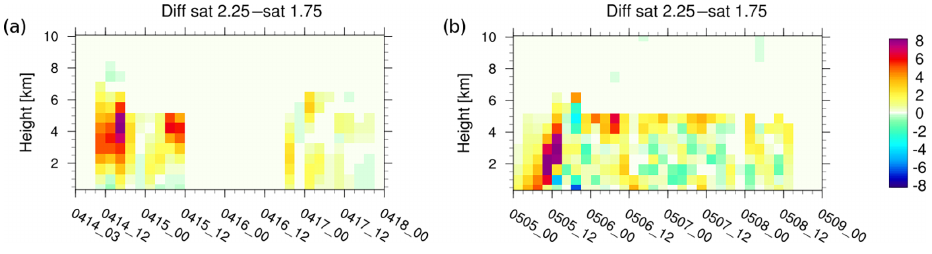
Figure 8. The difference in emissions (kgm − 1 s − 1 ) between the a posteriori source terms for the inversions using the 2.25 and 1.75 satellite data sets over the two periods in April (a) and May (b) .